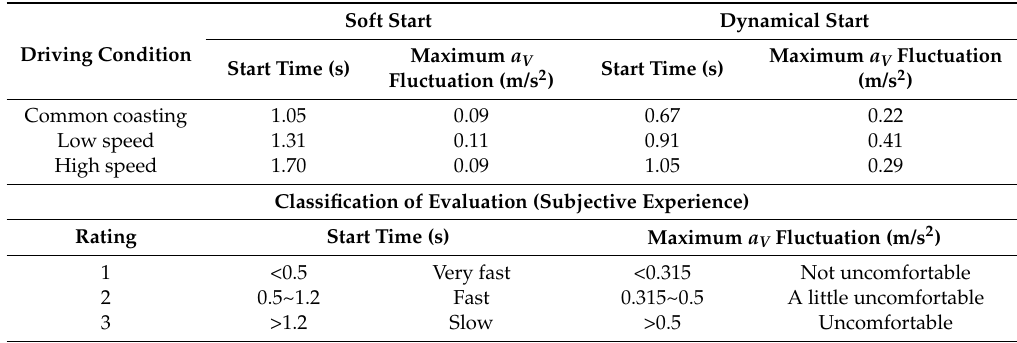
Table 3. Summary of simulation results and evaluation classification.